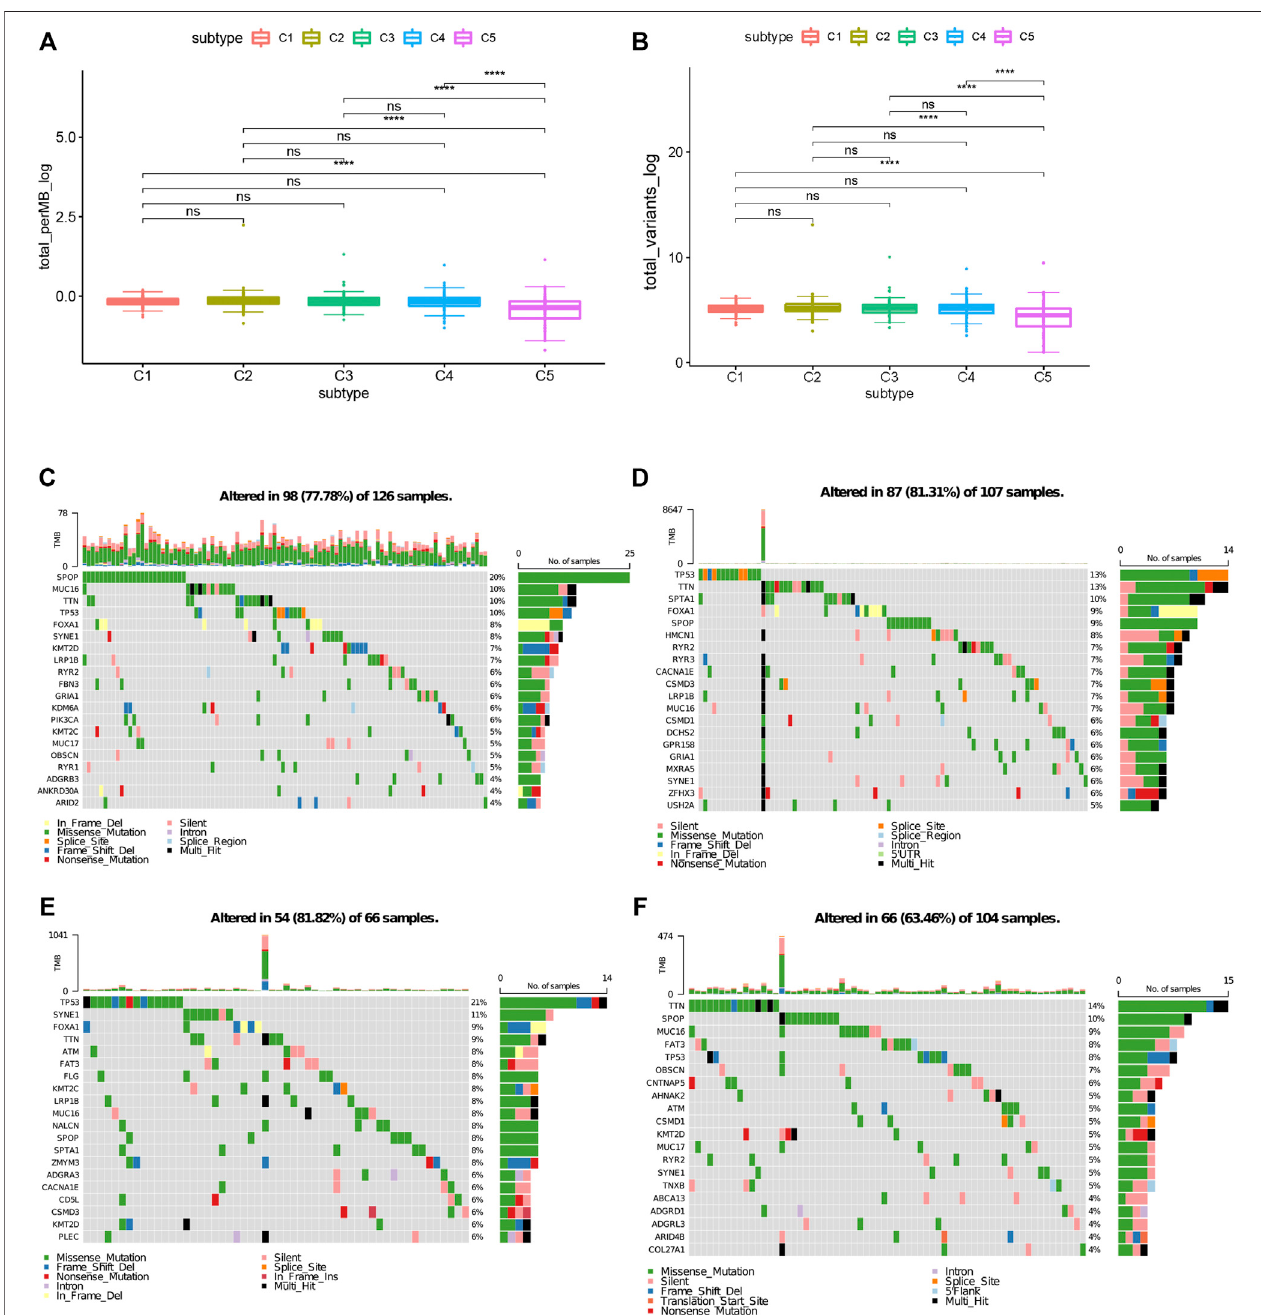
FIGURE 5 | Association between immune subtypes and TMB and mutation. (A) TMB and (B) mutation number in PRAD C1-C5. (C) Top highly mutated genes in PRAD immune subtypes C1. (D) Top highly mutated genes in PRAD immune subtypes C2. (E) Top highly mutated genes in PRAD immune subtypes C3. (F) Top highly mutated genes in PRAD immune subtypes C4. (G) Top highly mutated genes in PRAD immune subtypes C5. (H) Eleven highly mutated genes in PRAD immune subtypes. * p < 0.01, ** p < 0.001, *** p < 0.0001, and **** p < 0.00001.